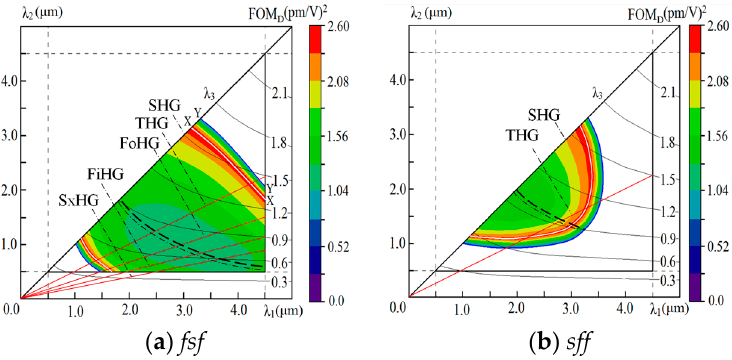
λ λ D ( 1 , 2 ) for KTP crystal with